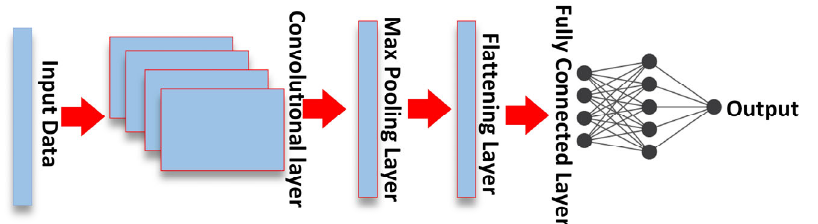
Figure 2. The structure of CNN network.